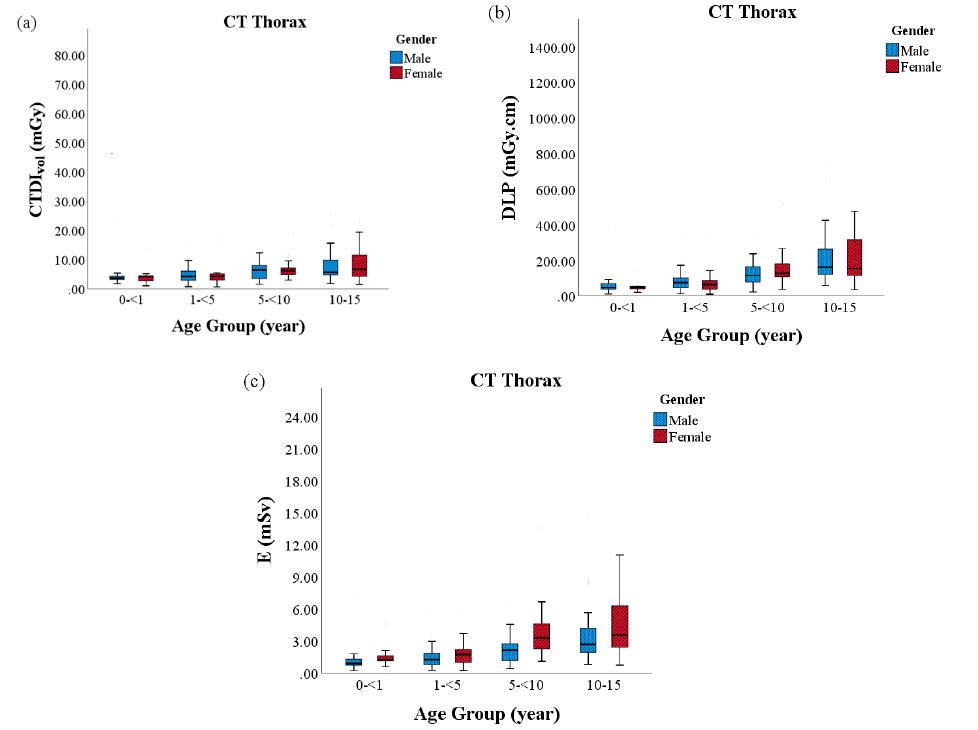
Figure 3. The radiation doses between sex and age in CT thorax: ( a ) volume computed tomography dose index (CTDIvol); ( b ) dose length product (DLP); and, ( c ) effective dose (E).